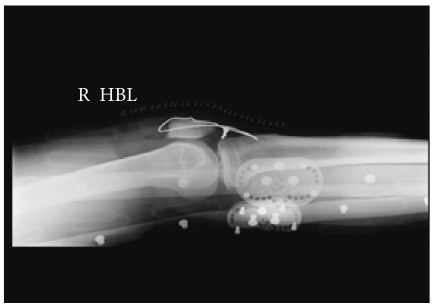
Figure 3: Postoperative right knee radiograph.